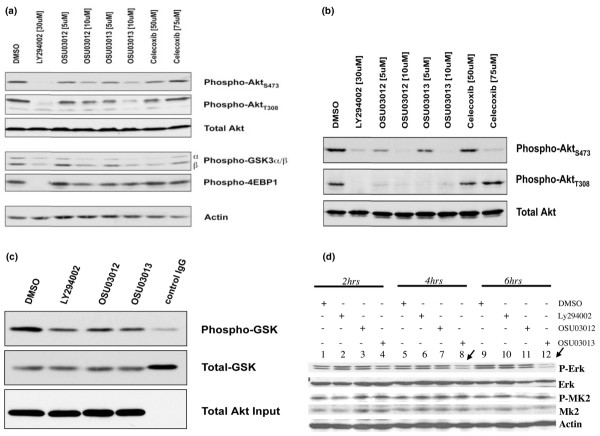
Impact of signal transduction inhibitors on Akt signalling. (a) The MDA-MB-453 cells were treated for 2 hours with Ly294002 (30 μmol/l), OSU03012, OSU03013 (5 or 10 μmol/l), or celecoxib (50 or 75 μmol/l). The Celecoxib analogues inhibited Akt phosphorylation at both threonine 308 and serine 473. Phosphorylation of the Akt substrates glycogen synthase kinase (GSK) and 4E binding protein (4EBP)-1 was subsequently attenuated. In contrast, celecoxib did not have an inhibitory effect. Ly294002 inhibited signal transduction through Akt, as expected. Total Akt and actin were unaffected by exposure to the signalling inhibitors. (b) T47D cells were also exposed to the drugs as described above and evaluated for phosphorylated Akt (P-Akt) using antibodies to Ser473 and Thr308. Total Akt was included as a control for loading. (c) Cells were treated as above and Akt kinase was measured against the substrate GSK. Each of the celecoxib analogues inhibited Akt kinase activity. The degree of inhibition was similar to that with Ly294002. There was minimal nonspecific kinase activity in the absence of Akt based on the IgG control. Total Akt was evaluated as a loading control to confirm that the loss of activity was not due to differences in experimental conditions. (d) The MDA-MB-453 cells were treated for 2, 4, or 6 hours with dimethyl sulphoxide (DMSO), Ly294002 (30 μmol/l), OSU03012 (10 μmol/l), or OSU03013 (10 μmol/l) and probed for P-Erk1/2, total Erk, P-MK2, total MK2 and actin.